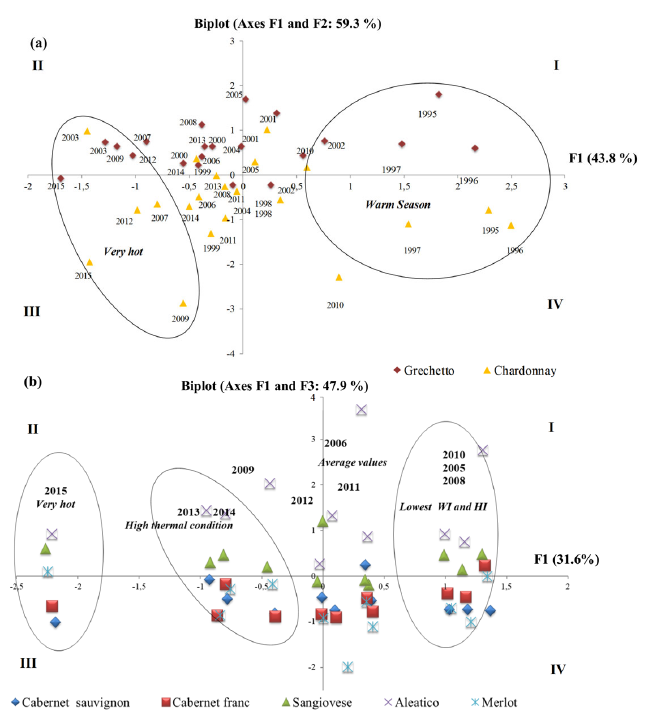
Figure 9. Biplots of the climate indices and berry quality traits along principal components 1 (F1) and principal components 2 (F2) for the white grape varieties (CH and GR) ( a ); and component F1 and F3 for red grape varieties (CS, CF, M, S and A) ( b ). CH, Chardonnay; GR, Grechetto; CS, Cabernet sauvignon; CF, C. franc; M, Merlot; S, Sangiovese; and A, Aleatico. Roman numerals represent the four quadrants of the Cartesian coordinate